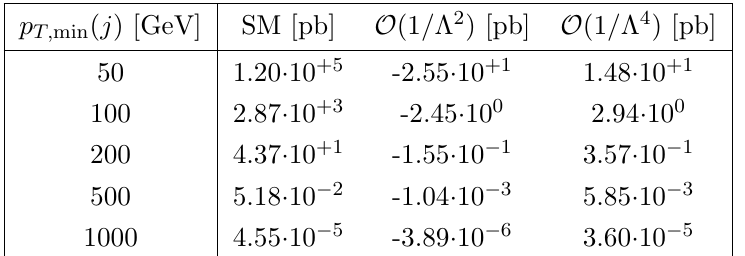
Table 2 . Cross-sections for the production of four partonic hard jets, isolated using di(cid:11)erent values of a p T; min -cut and (cid:1) R = 0 : 4. The scale (cid:3) is set to 5 TeV. In the computation of the result of order O (1 = (cid:3) 4 ), only the contributions from at most one insertion of the operator O G in the amplitudes are